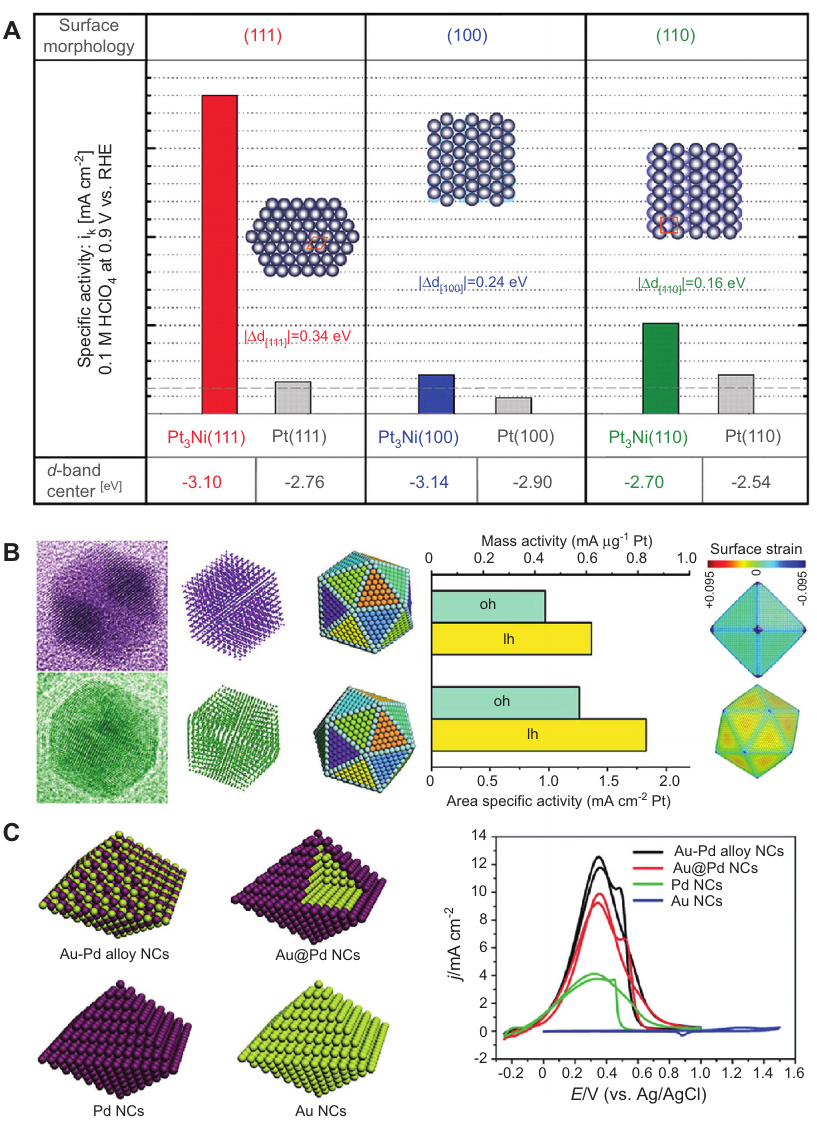
Ni surfaces of different facets – ORR activity vs. d-band center. Adapted with permission from Ref. [1]. Copyright 2007 Figure 1 (A) Pt and Pt 3 American Association for the Advancement of Science. (B) Pt Ni octahedral and icosahedral nanocrystals – surface strain fields and strain- 3 induced change in ORR mass specific activity. Adapted with permission from Ref. [11]. Copyright 2012 American Chemical Society. (C) Au-Pd bimetallic octahedra – atomic distribution-dependent activity for formic acid oxidation reaction. Adapted with permission from Ref. [12]. Copyright 2011